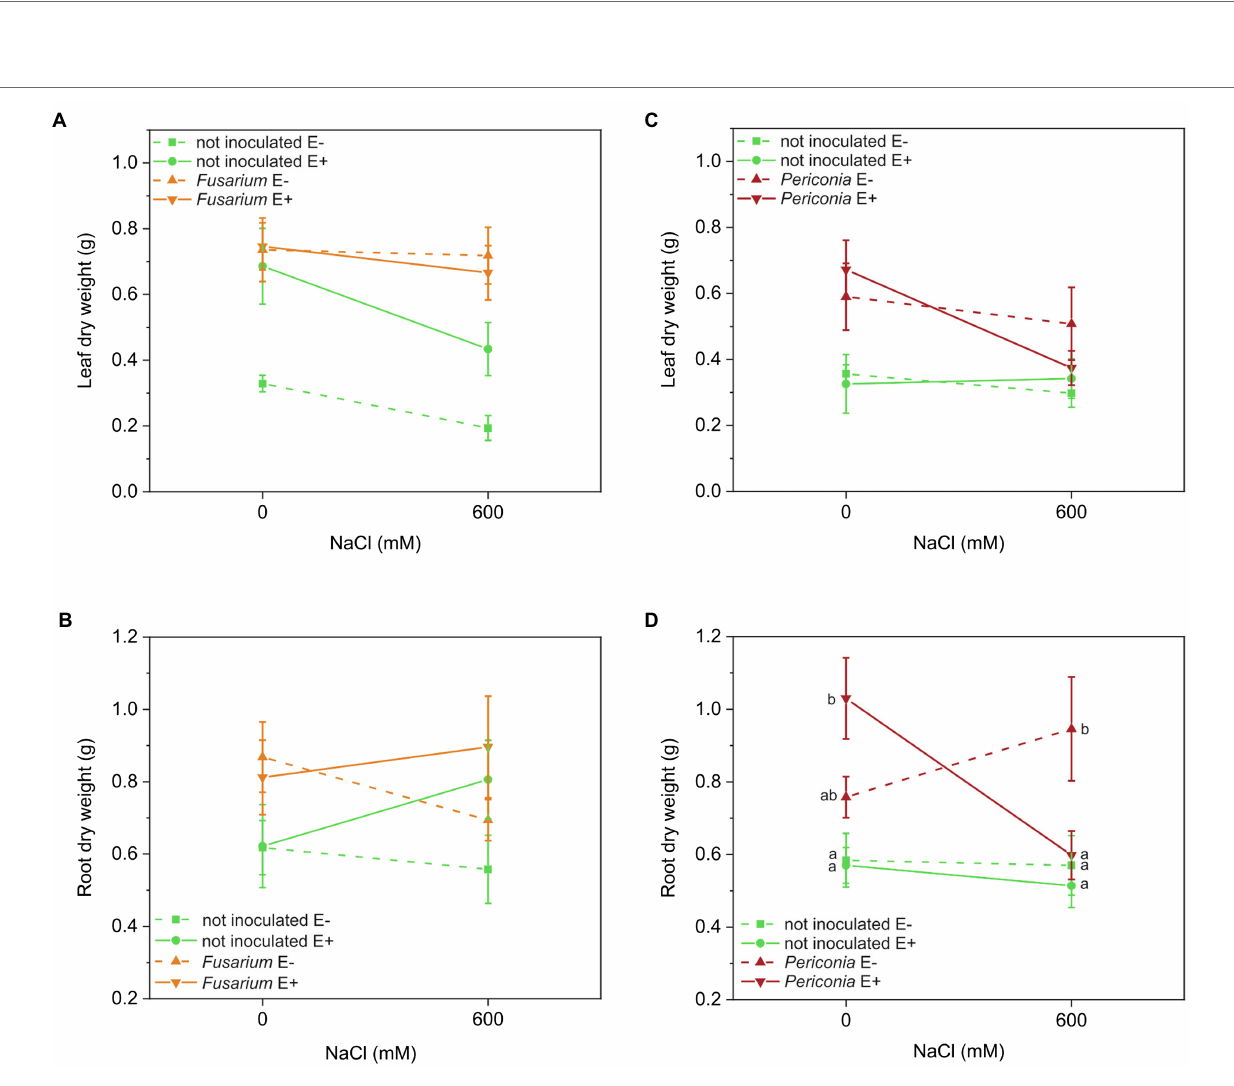
FIGURE 2 | Leaf and root biomass produced at two different salinity treatments (0 and 600 mM NaCl) in two FRP lines, EB15 (A,B) and TH12 (C,D) , each one composed by clones symbiotic with Epichloë festucae (E + ) or Epichloë free (E – ), and inoculated with Fusarium oxysporum T48 (orange), Periconia macrospinosa T131 (dark red), or uninoculated (green). Where a significant [salinity × Epichloë × root endophyte] interaction occurred, different means are indicated by different letters.